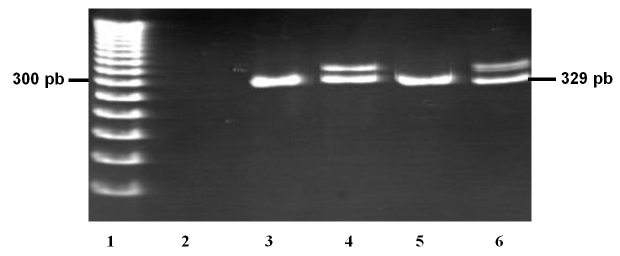
FIGURE 1 - PCR products of FLT3-ITD, analyzed by gel electrophoresis. Reverse view of ethidium-bromide-stained 12% polyacrylamide gel FLT3-ITD was detected as extra-bands in addition to normal band of 329 bp. Line 1- Molecular weight marker (50 bp); Line 2-Water control; Line 3-Patient sample wild type; Line 4- Patient sample with FLT3-ITD mutation; Line 5-wild type control; Line 6-) FLT3-ITD mutation control.